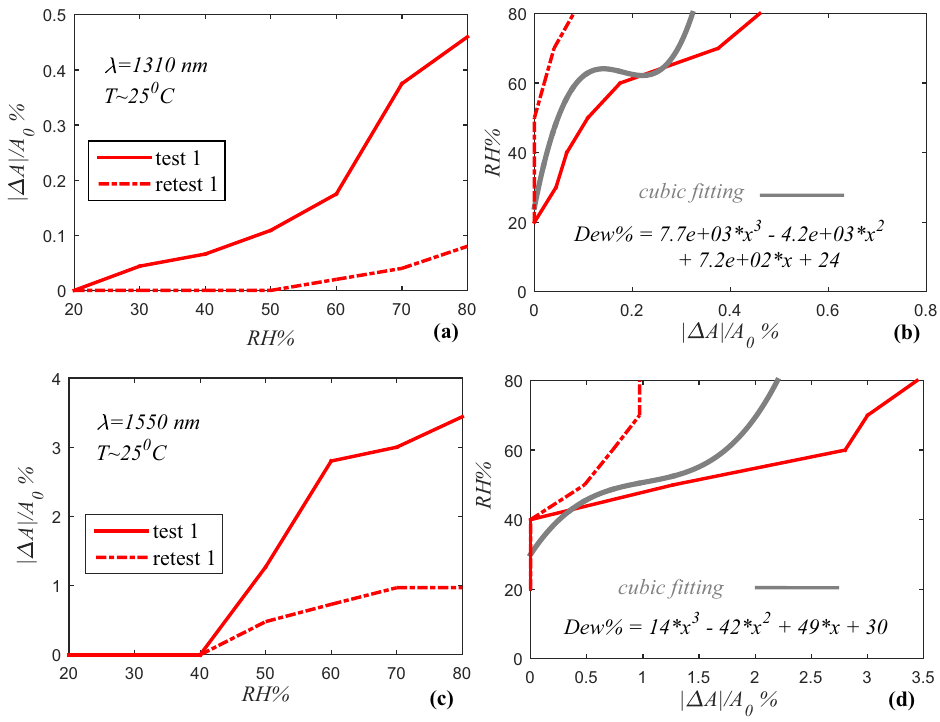
Figure 7. Repeatability of RDA as a function of RH for G/GO in 1310 nm ( a ) and 1550 nm ( c ) wavelengths; reversing and fitting curves to calculate RH formulation in 1310 nm ( b ) and 1550 nm ( d ) (dash-line curves are rapid retest of line curves).